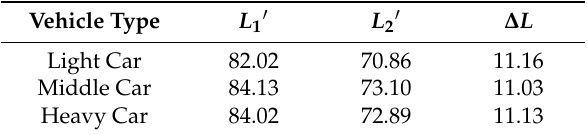
Table 3. Data collected in the noise attenuation experiment with distance (dB).